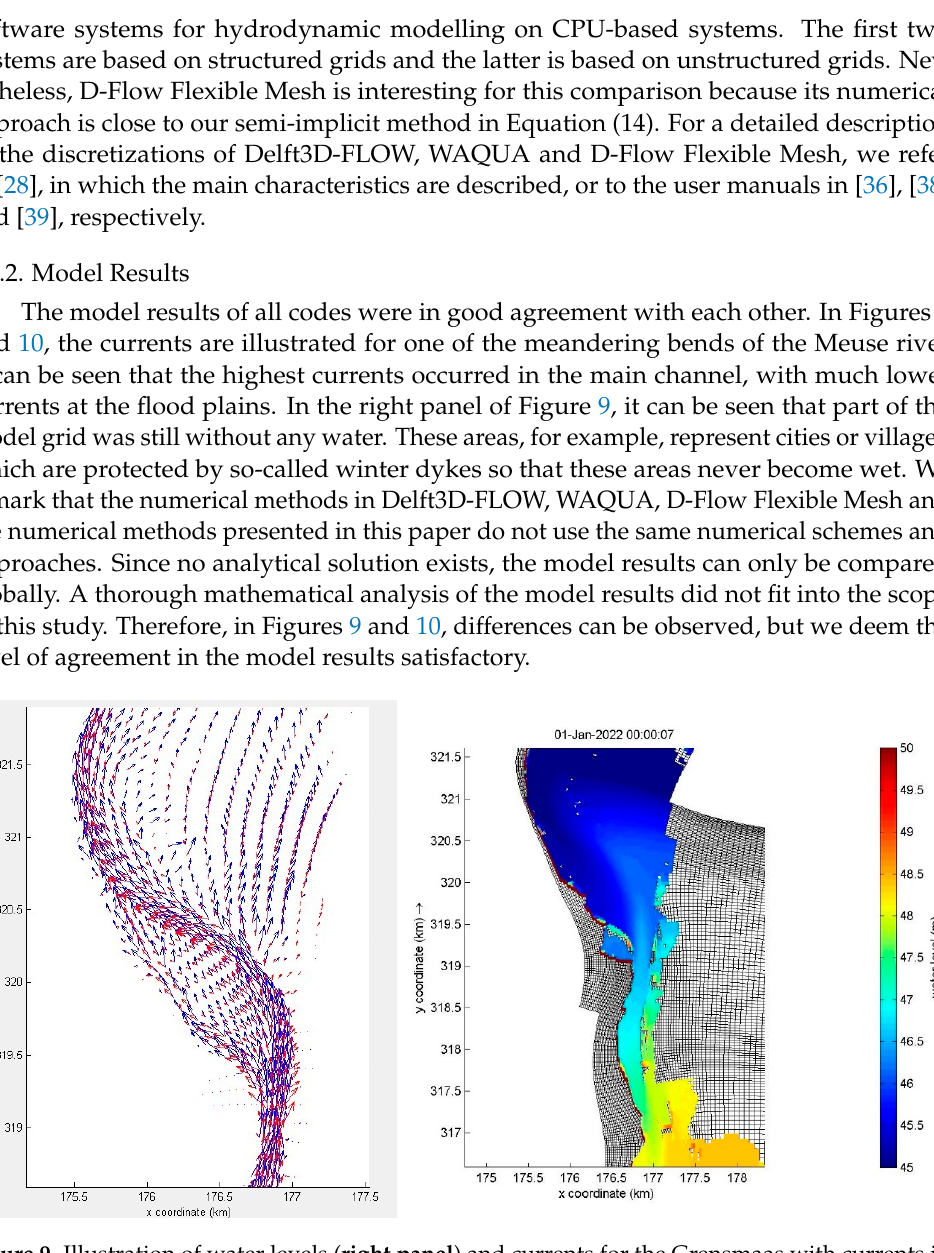
Figure 10. Illustration of currents for the “Semi-impl” method ( left panel ) and currents for WAQUA ( right panel ).